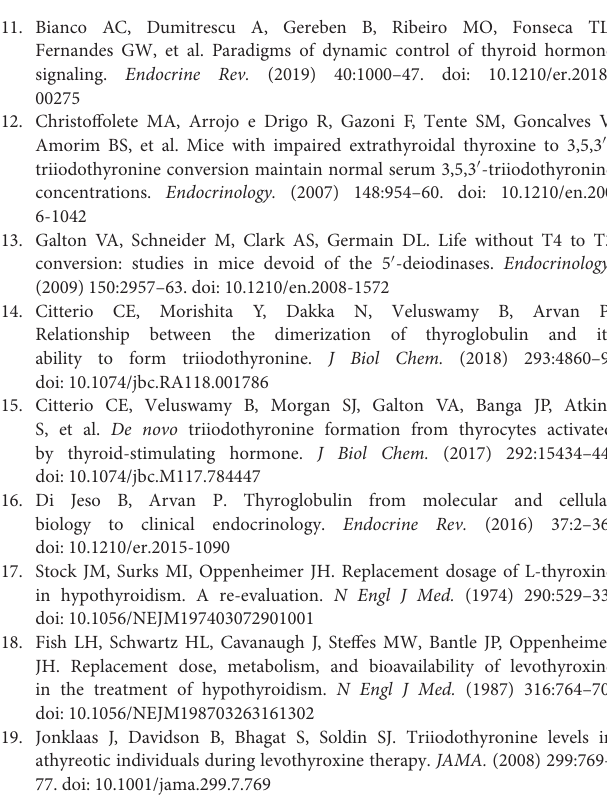
( Table 1 ). The development of slow release formulations that could be used in humans has been in the works for years. Claims of slow release LT3 formulations based on